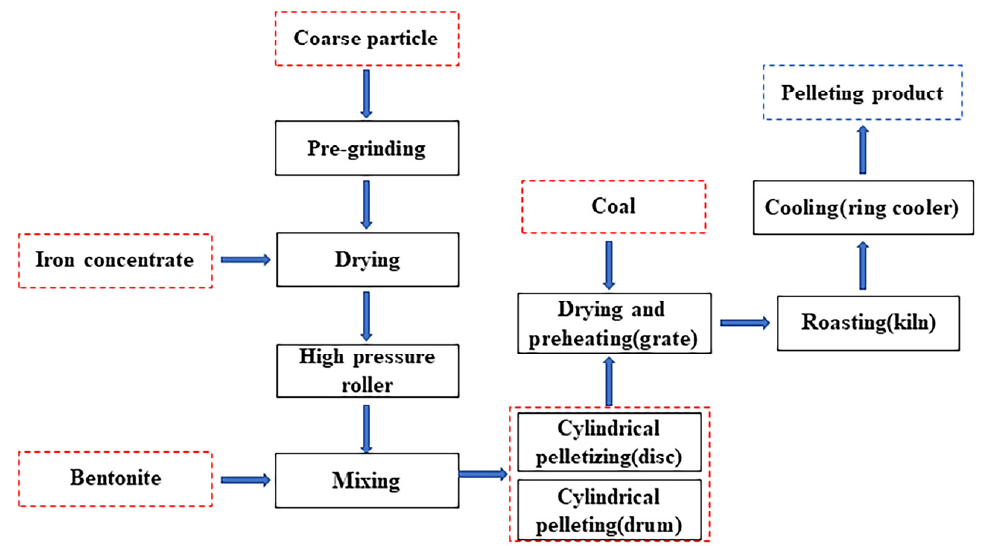
Figure 1. The process of producing iron ore pellets in factories of BAOWU [19].